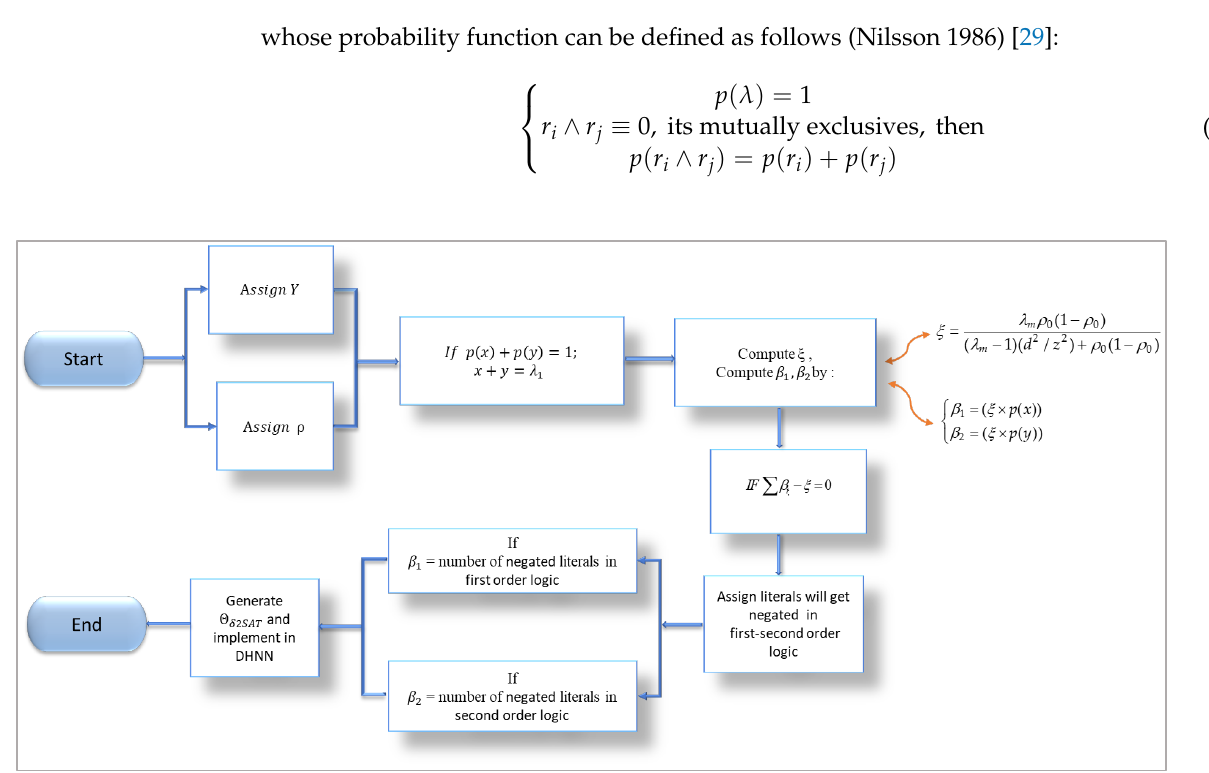
Figure 1. Block diagram of the proposed S-type Random 2 Satisfiability logic Θ